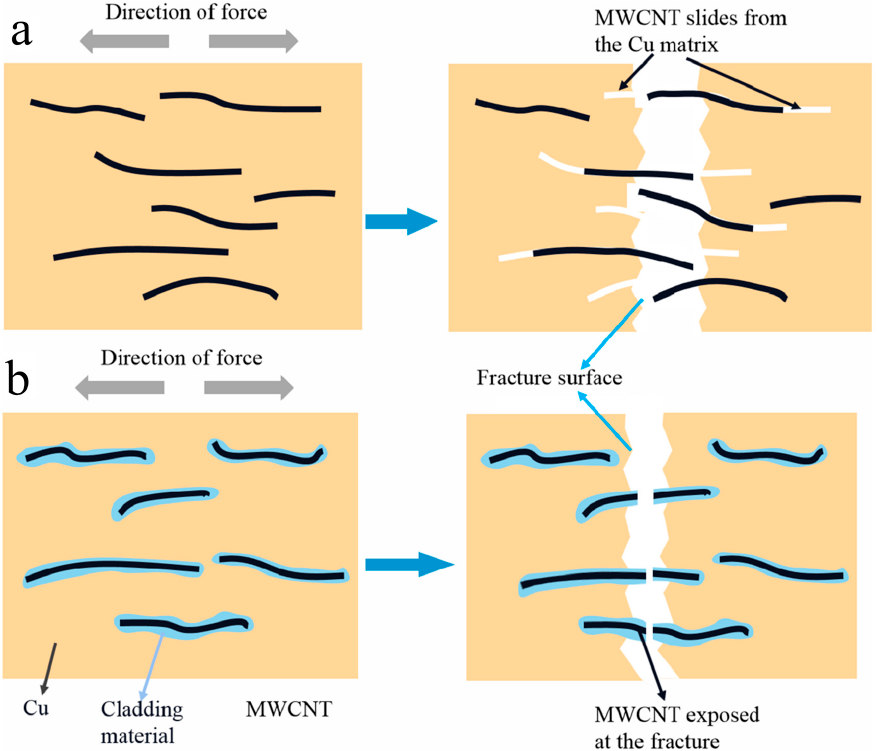
Figure 9. Schematic diagram of the tension fracture of ( a ) B-CNTs and ( b ) the coated MWCNT- reinforced copper composite.